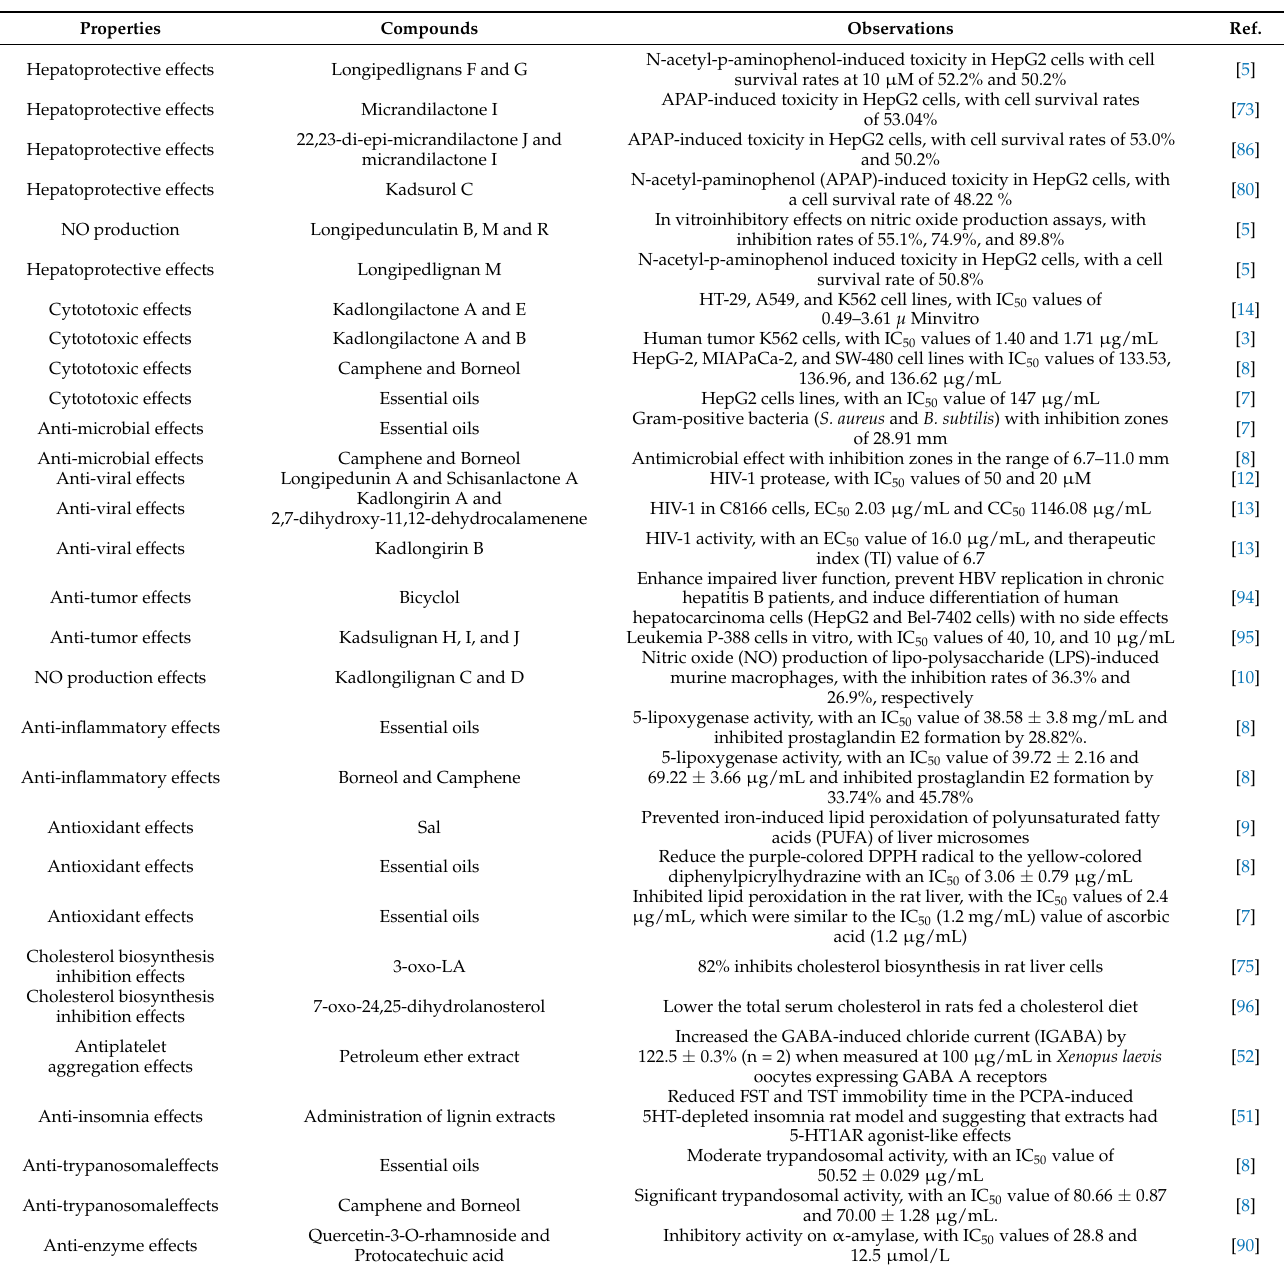
Table 4. Validated pharmacological uses of K. longipenduculata